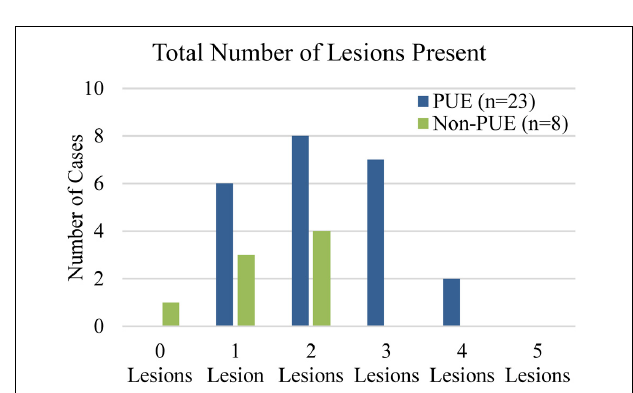
FIGURE 6 | Lesions present in bottlenose dolphins. PUE cases exhibited a higher total number of abdominal and/or pulmonary lesions (range: 1–4) than non-PUE cases (range: 0–2). Only PUE cases exhibited three or more